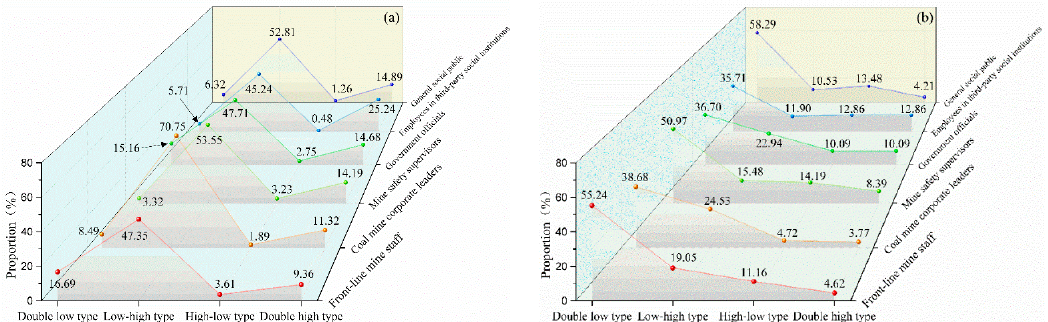
Figure 5. Analysis of attention to occupational safety and health and WTP by subjects with different identities. ( a ) Cross analysis of attention and tax WTP; ( b ) Cross analysis of attention and individual income WTP.